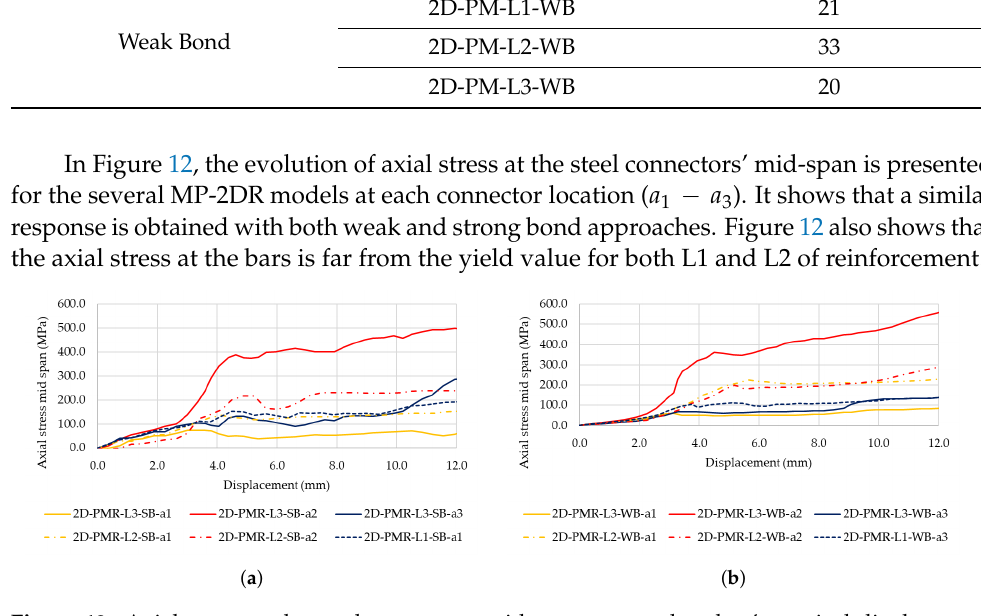
Figure 12. Axial stress at the steel connectors mid-span versus the plate’s vertical displacement diagram: 2D-PMR models for various reinforcement levels and bond strength. ( a ) Strong bond; ( b ) Weak